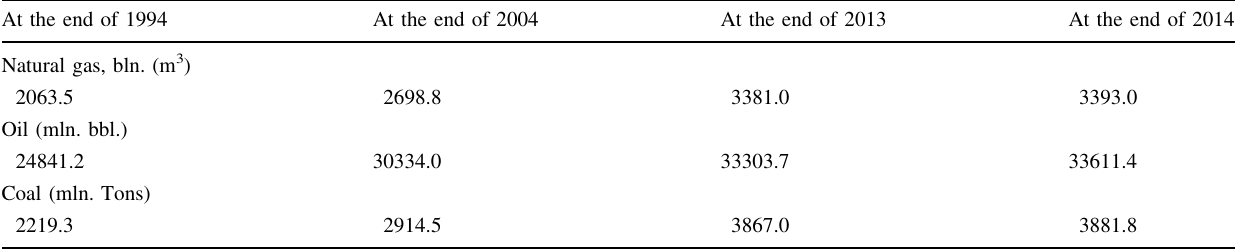
Table 2 The consumption of non-renewable energy sources in the world (Statistical Review of World Energy 2002, 2005, 2014, 2015; International Energy Outlook 2016) At the end of 1994